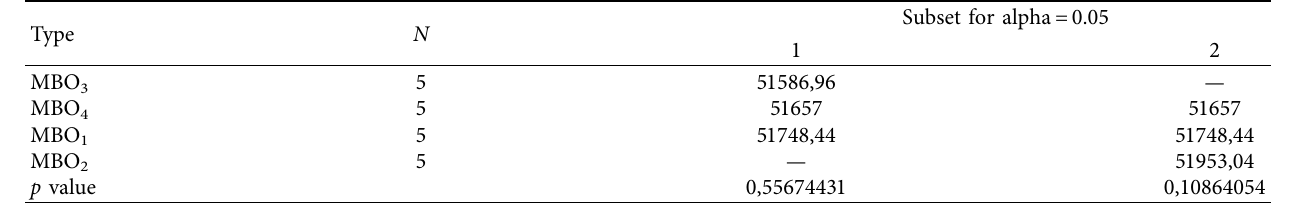
Table 15: Tukey’s test for the pcb442